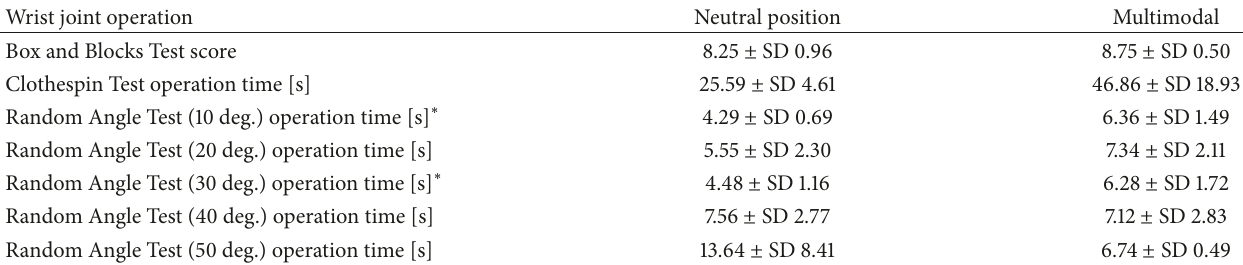
Table 1: Means of operation times and scores ( ∗ 𝑝 < 0.05, 𝑁 = 4 ).